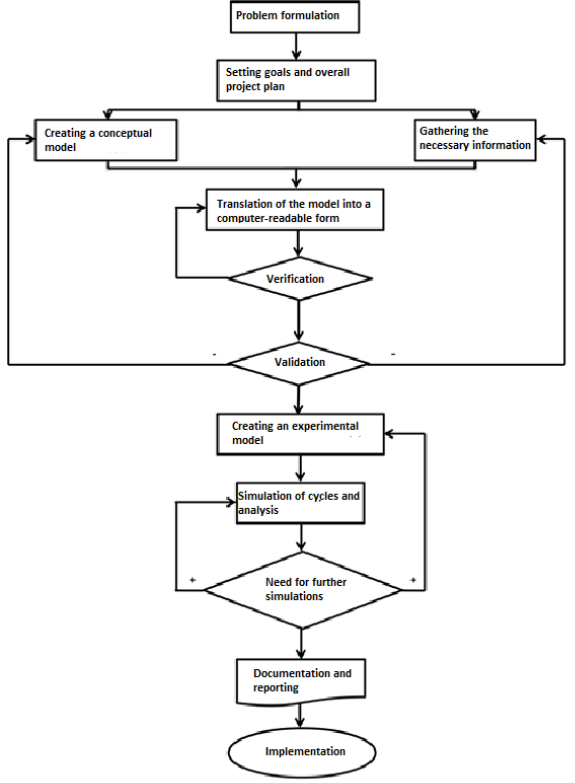
Figure 2. Algorithm for creating a simulation model.